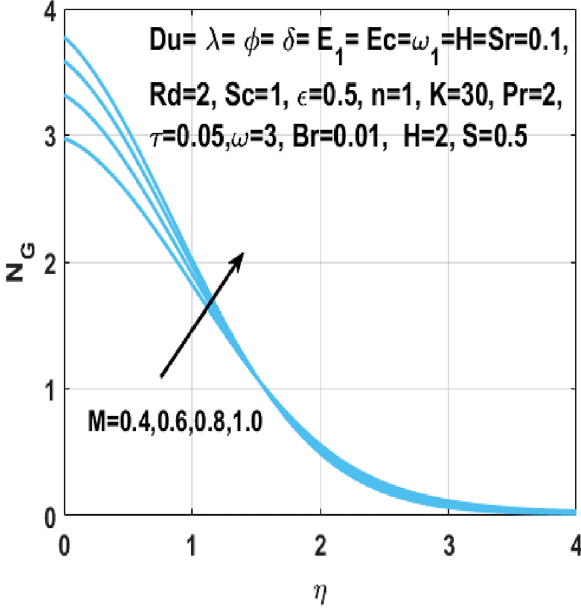
Figure 18. Impact of M on N G .